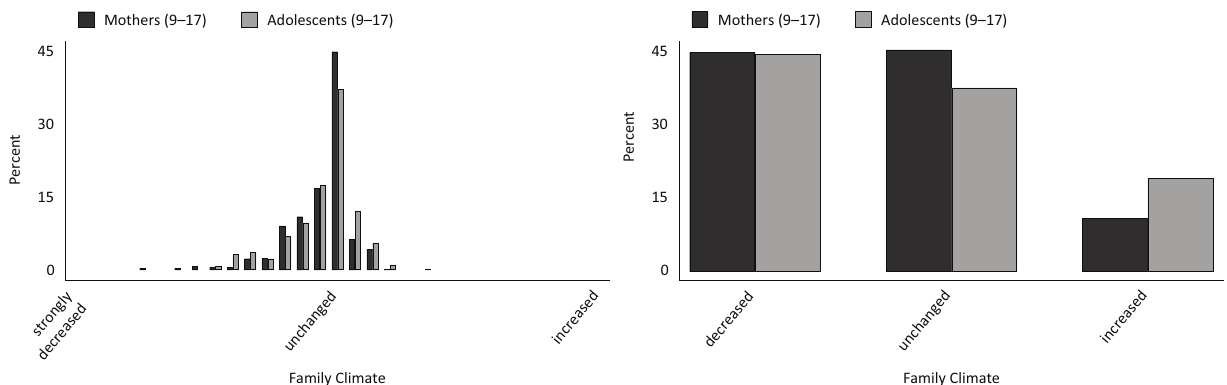
Figure 1. Changes in family climate: Adolescents and mothers. Notes: N = 306 mothers of children aged nine to 17 and 273 adolescents; weighted. Source: Authors’ work based on Kuger et al. (2020, 2021). decrease in family climate (54 vs. 44%; Figure A1 in the Supplementary File).